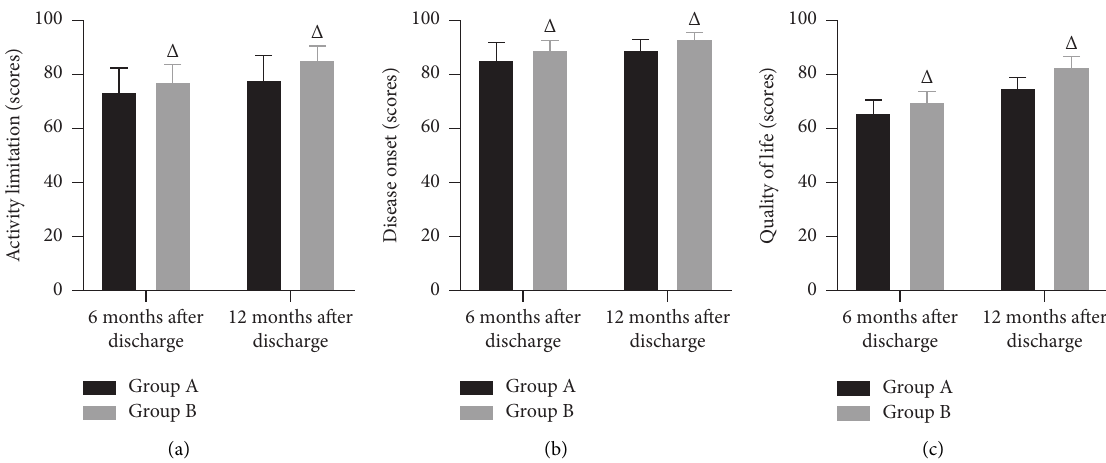
Figure 5: SAQ score. Note . (a). Activity limitation (scores). (b). Disease onset (scores). (c). Quality of life (scores). Comparison with group A, △ P < 0 .